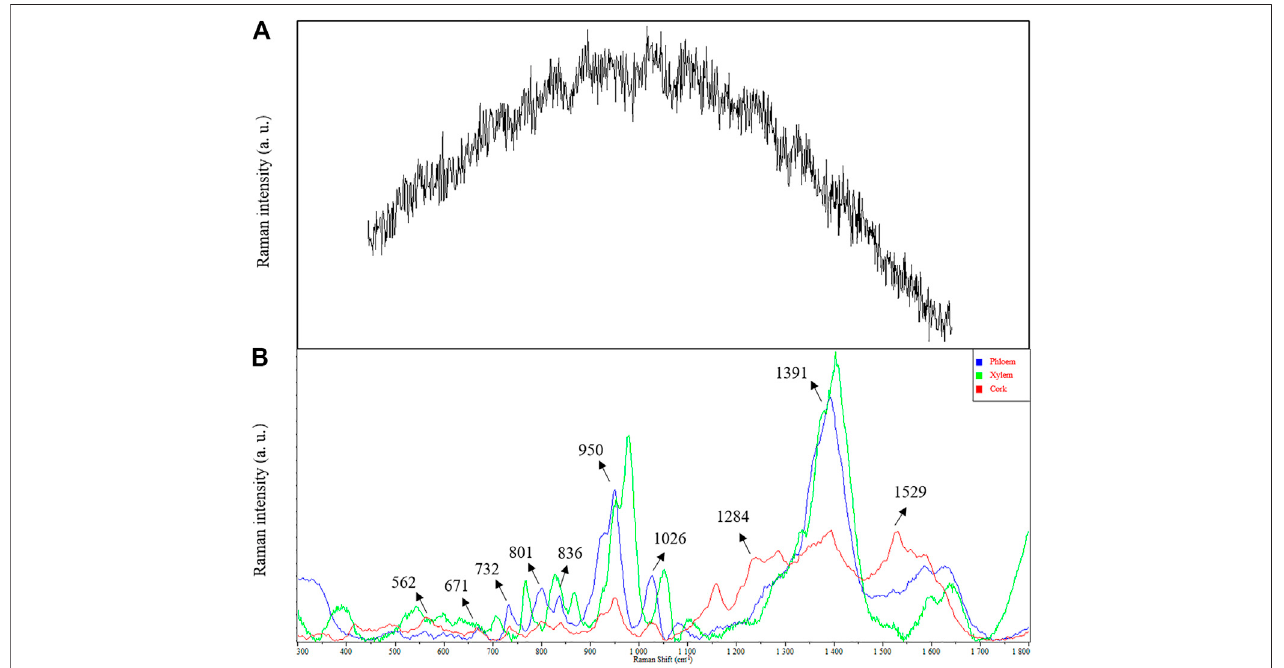
FIGURE 2 | Comparison in SERS and conventional Raman spectra of Astragalus mongholicus Bunge. (A) conventional Raman spectra. (B) SERS.